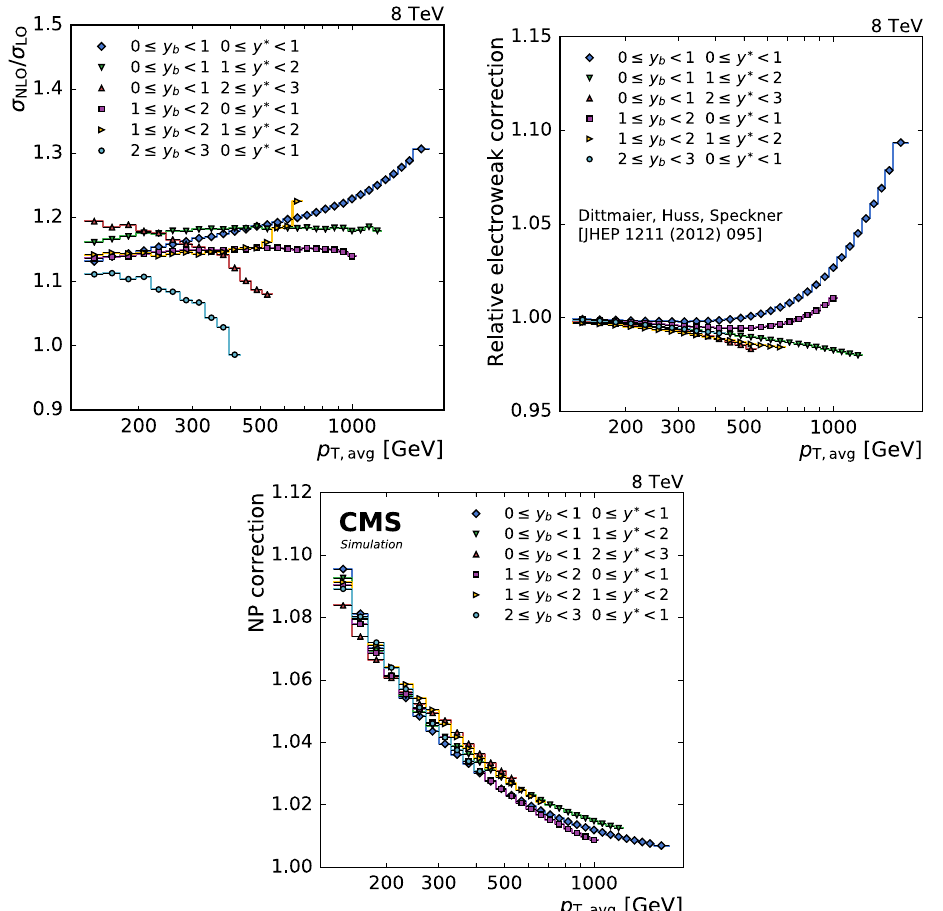
The NLO QCD correction has been derived with the same NLO PDF in numerator and denominator and is included in the NLO prediction by